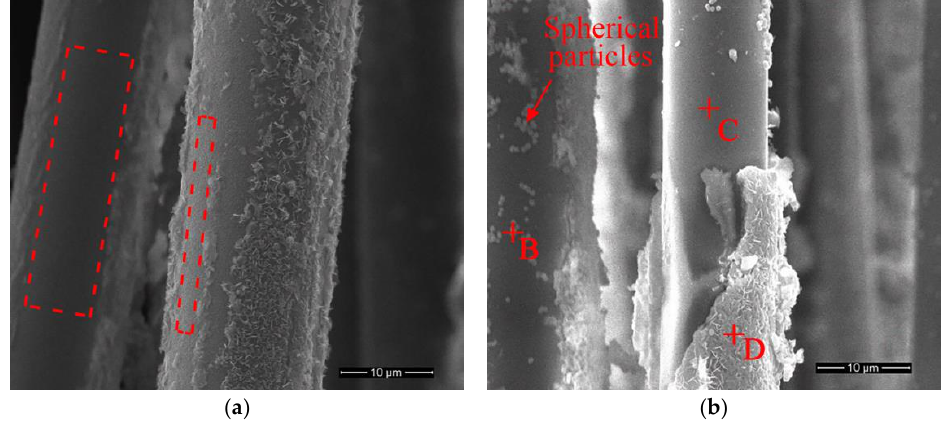
Figure 7. SEM images of basalt fibers treated in NaOH solution at 70 °C for 6 h: ( a ) 1 mol/L; ( b ) 4 mol/L.